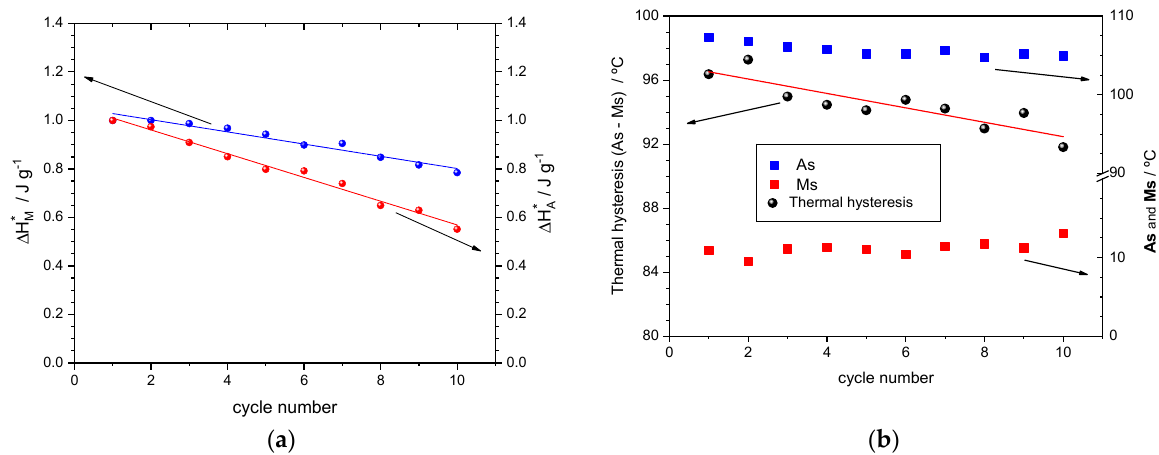
* , absolute , absolute A A